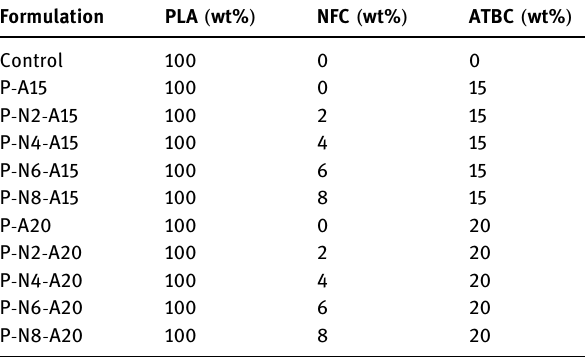
Table 1: Composites formulations